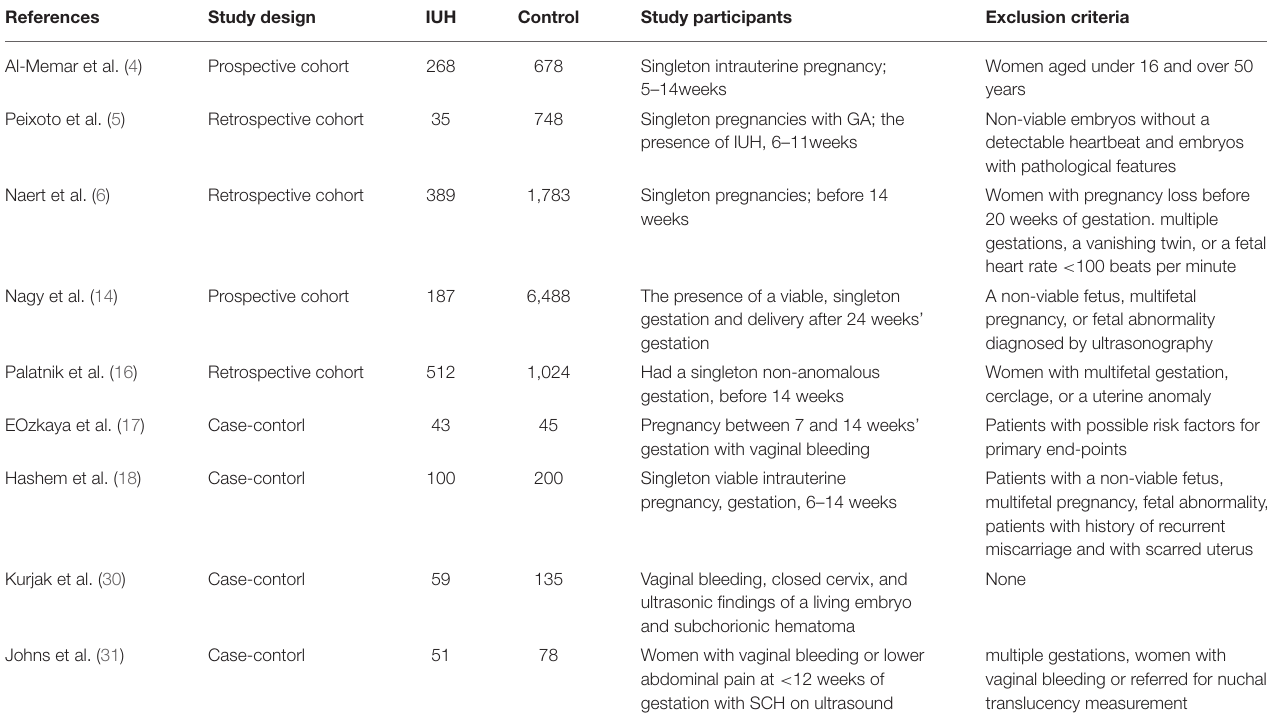
TABLE 1 | Characteristics of the studies included in the